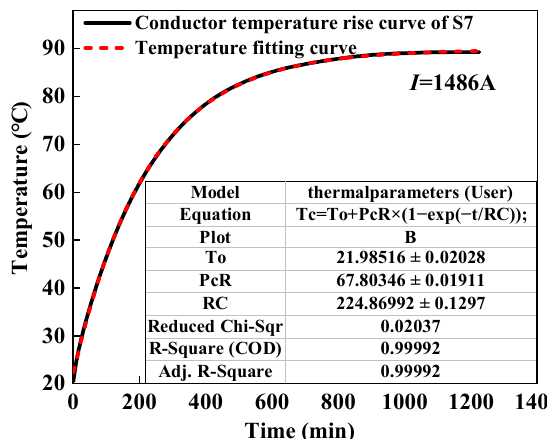
Figure 8. First-order RC transient thermal circuit.